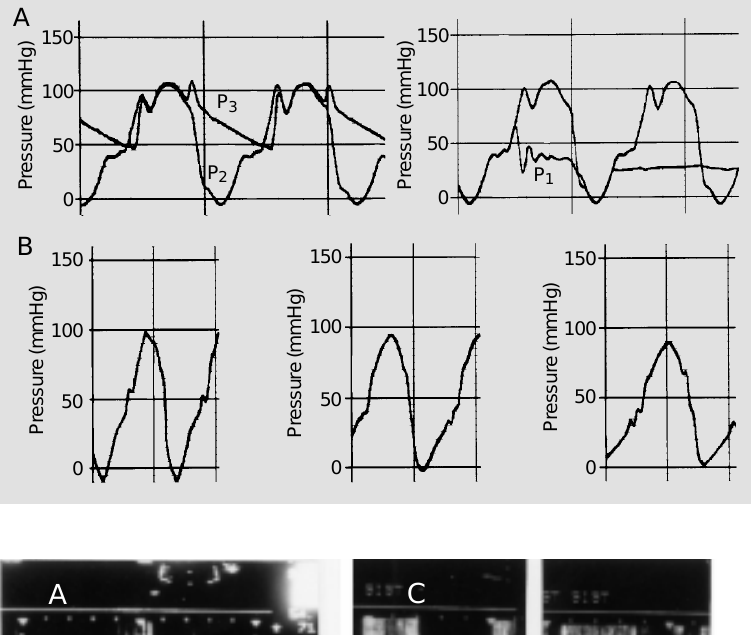
Figure 2 - Panel A , Pressure curves were recorded in the “atrial” (P 1 ) and “ventricular” (P 2 ) chambers and also at the “peripheral circulation” (P 3 ) level of the flow model. Panel B , Pressure curves were recorded at the “ventricular” chamber level when the rate of pressure increase during forward movement of the piston was modified independently.